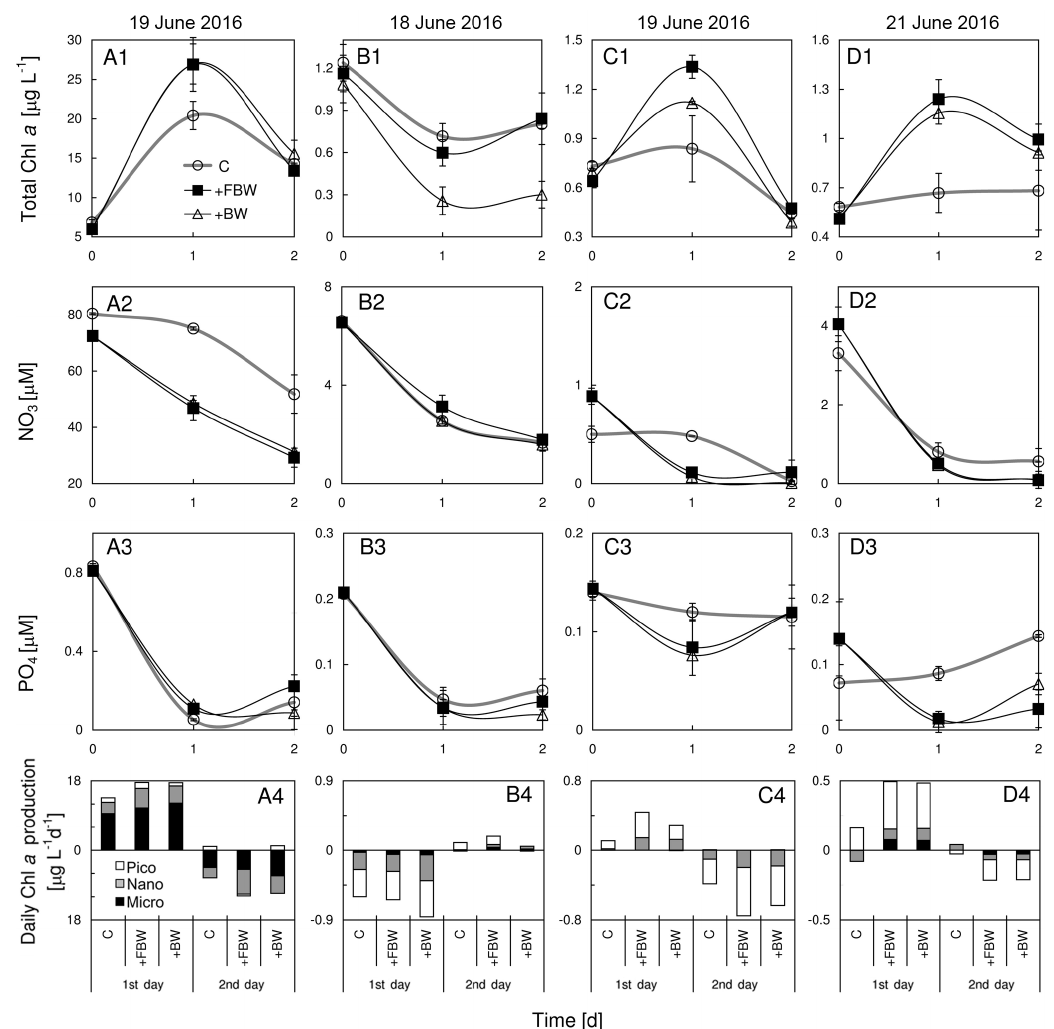
Figure 9. Responses of total chlorophyll a , nitrate, phosphate and size-fractionated rate of daily chlorophyll a production in the surface water to the addition of local bottom waters at stations (a1)–(a4) S2, (b1)–(b4) S4, (c1)–(c4) S6, and (d1)–(d4) S7 during June 2016. BW is bottom water and FBW is filtered bottom